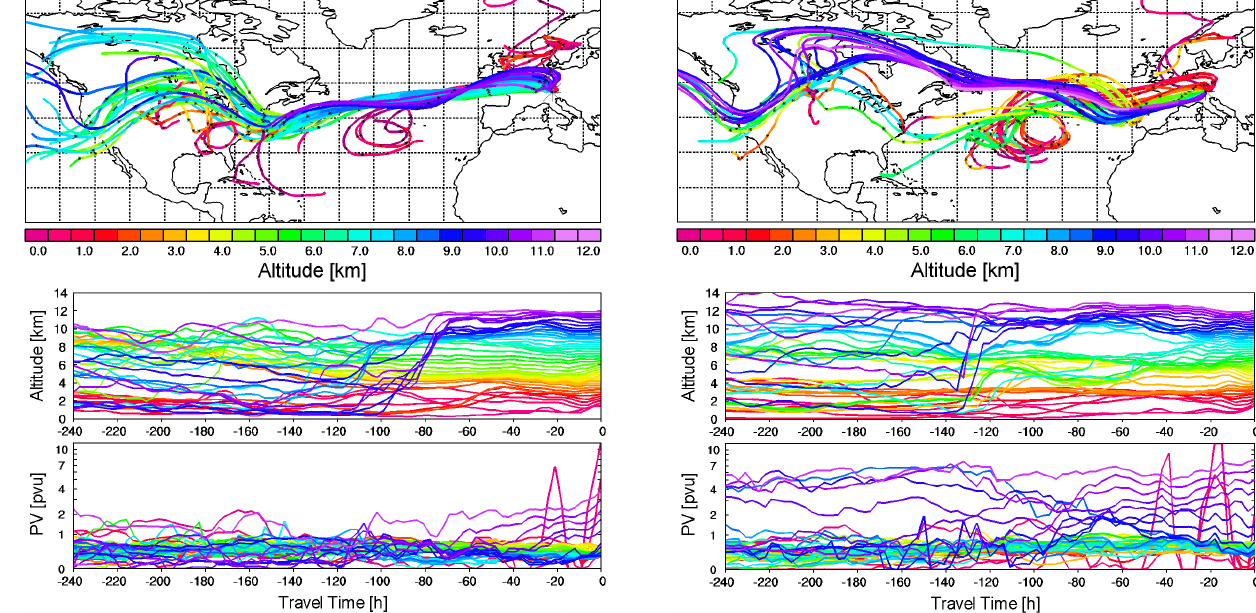
Fig. 15. Same as Fig. 14, but for 23 July 2001, 19:00CET (cor- responding to label 3 in Fig. 13); some of the upper-tropospheric trajectories reach altitudes above 12km during the earliest